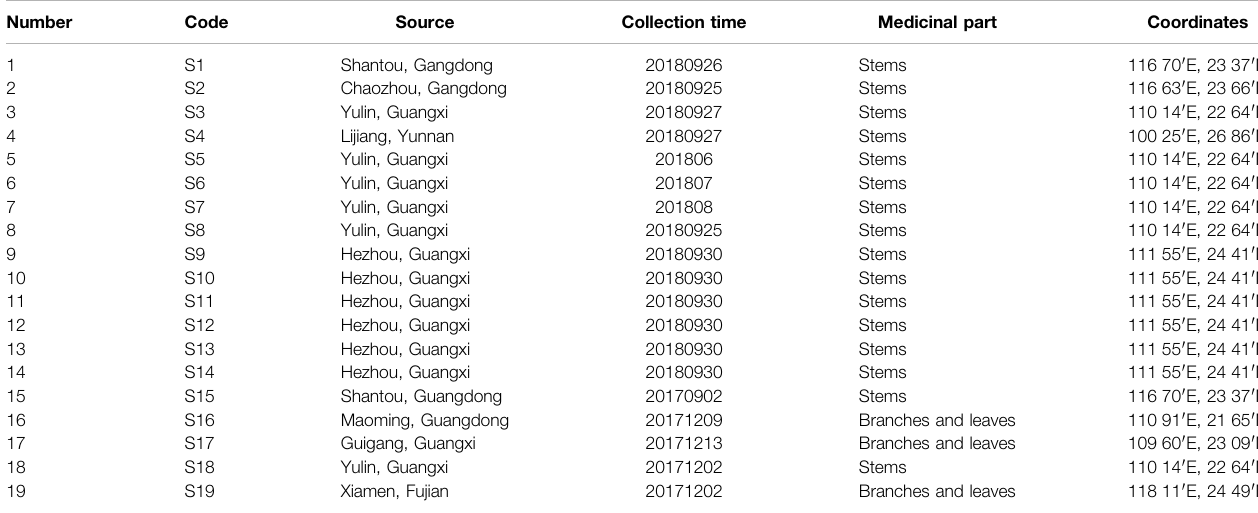
TABLE 1 | Sample information of